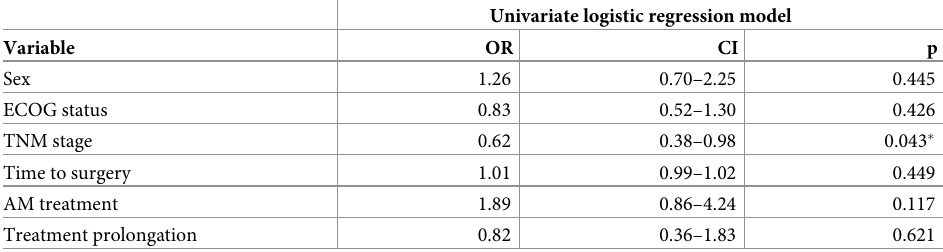
Table 5. Logistic regression model exploring predictors for tumour